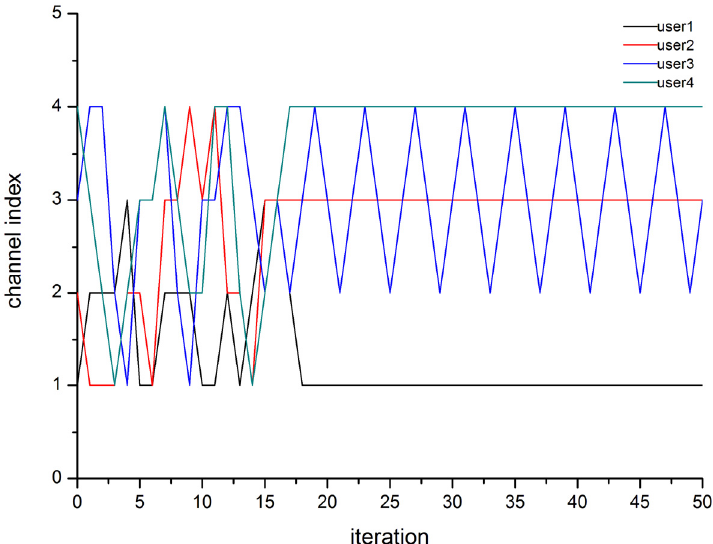
Figure 6. The simulation result of general CR spectrum allocation algorithm with four